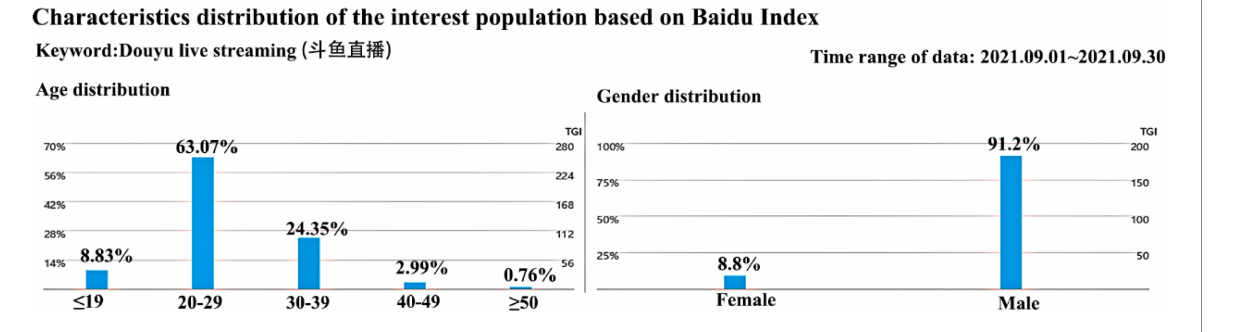
FIGURE 3 Gender and age distribution of Douyu live streaming in the Baidu Index.